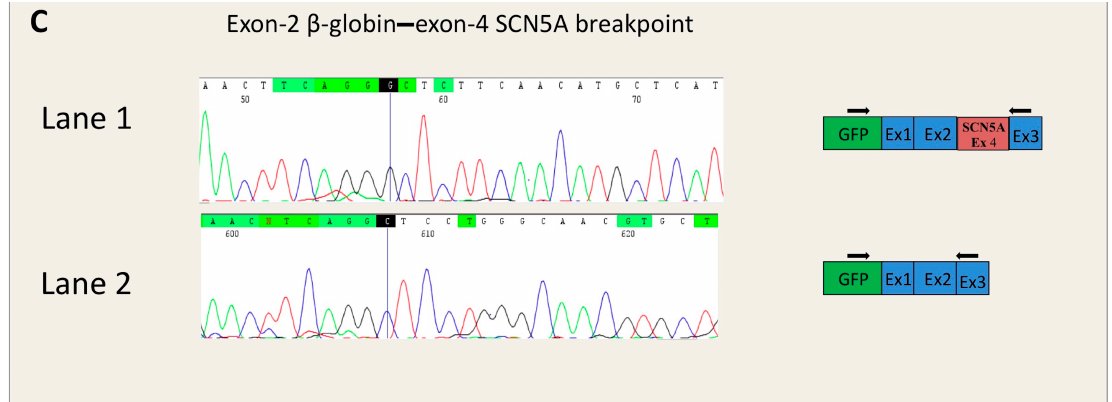
Figure 4. Effect of the SCN5A ‐ c.393 ‐ 5C>A mutation on the splicing mechanism. ( A ) Schematic representation of the splicing process in pMGene ‐ SCN5A constructs (WT, upside; mutated, downside). The red arrow shows the position of the mutation. The blue boxes represent the exons of human β‐ globin, the red box represents the SCN5A ‐ exon 4 cloned in the pMGene vector. The black arrows indicate the primers used for PCR analysis; ( B ) RT ‐ PCR analysis of mRNA extracted from cell lines transfected with pMGene ‐ SCN5A (WT or mutated). Lane 1 : pMGene ‐ SCN5A ‐ WT; Lane 2 : mutated pMGene ‐ SCN5A ; Lane 3 : Marker VI (Roche Diagnostics); ( C ) Electropherograms obtained from DNA sequencing of the fragments shown in panel B and relative splicing results (Black, red, green and blue peaks represent the G, T, A, and C bases, respectively). The blue lines in the electropherograms show the end of exon 2 of β‐ globin.